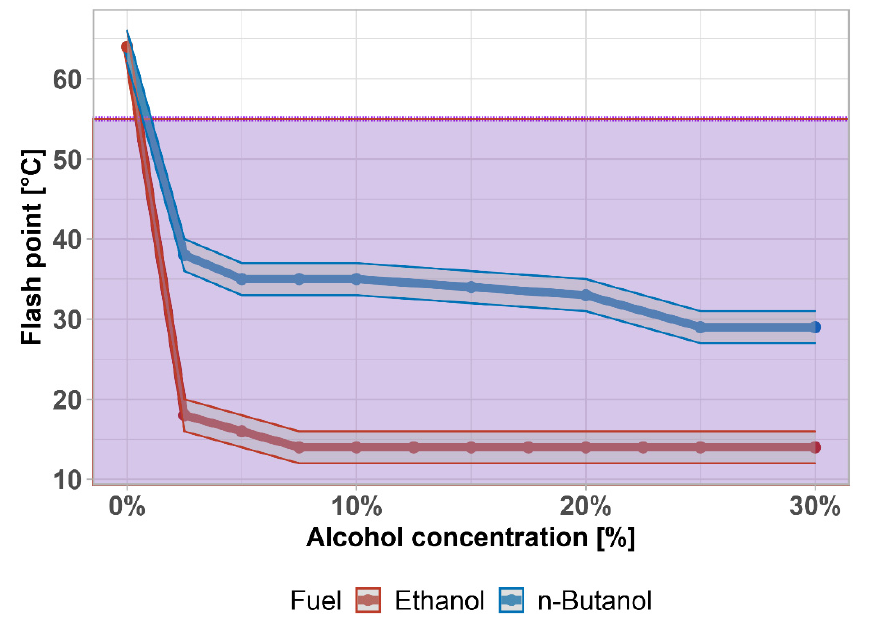
Figure 4. Flash point of diesel fuel–alcohol mixtures. Purple area highlights exceeding the limit given by the standard.